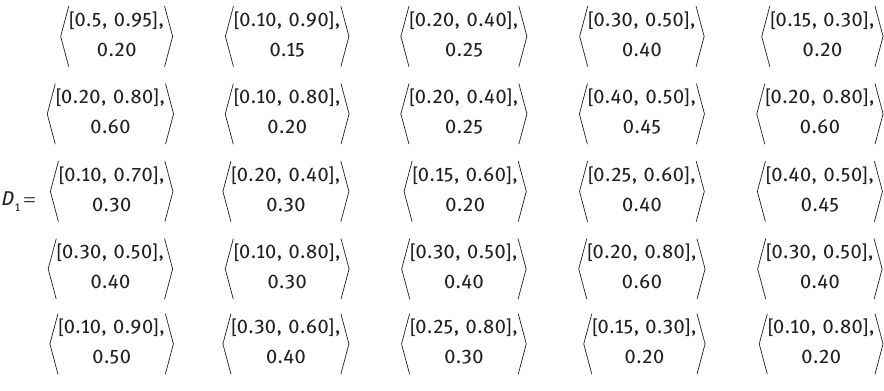
Table 7: Decision Matrix 1.